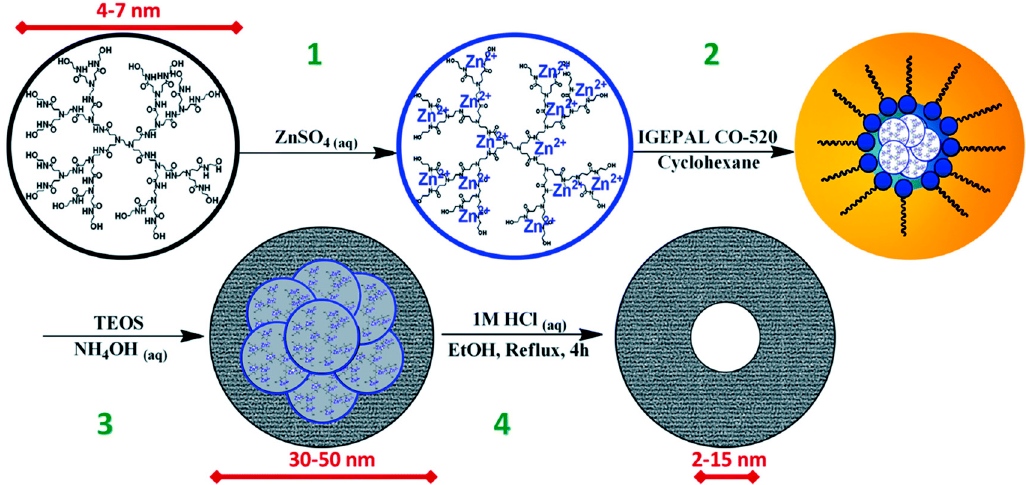
Figure 2. Scheme for total synthesis of dendrimer encapsulated mesoporous silica NPs. Step (1) inoculation of dendrimer with metal ions, (2) formation of reverse microemulsion with disperse phase (blue) and continuous phase (orange), (3) base catalyzed silica formation, and (4) acid catalyzed etching of metal encapsulated dendrimers. Adapted from [45].